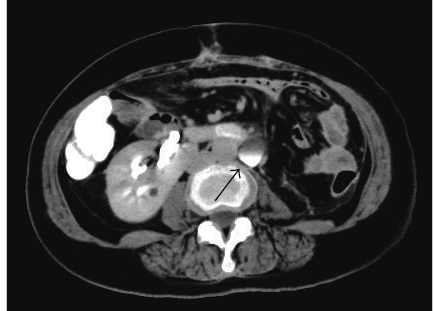
Figure 5: Postoperative donor CT images with contrast enhance- ment showed a site of fluid collection on the cut edge of the isthmus